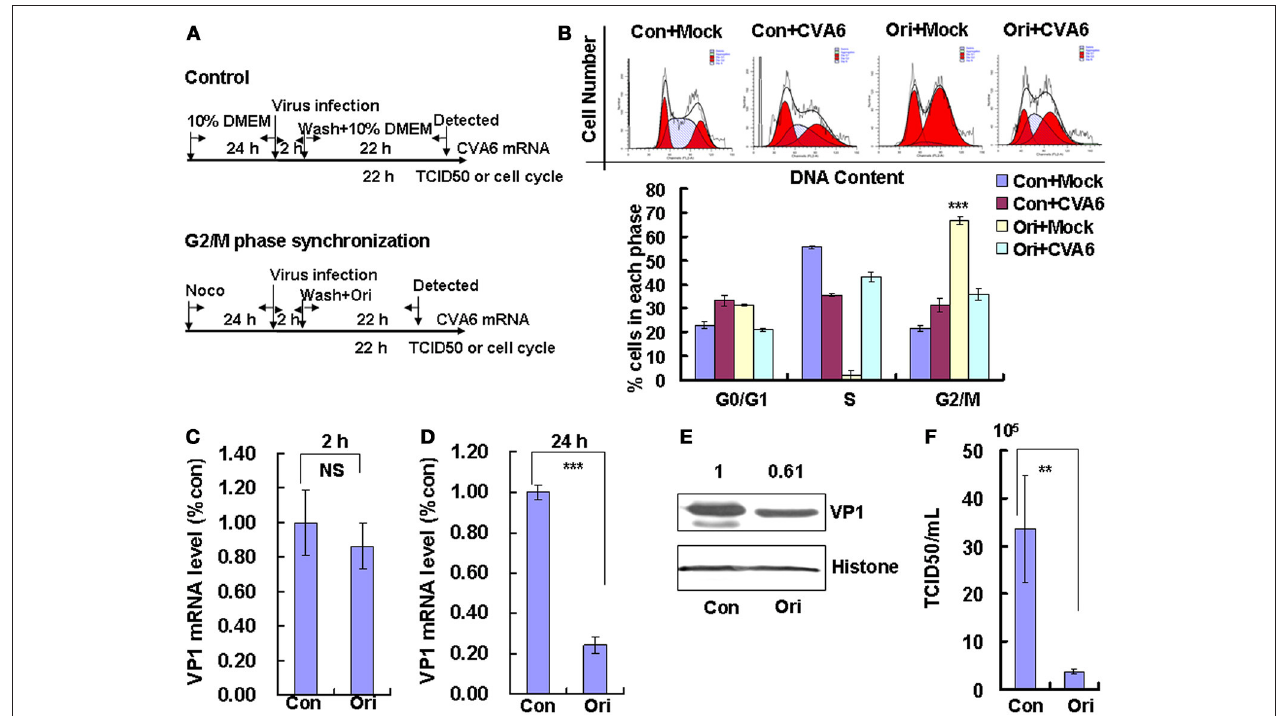
FIGURE 5 | G2/M-phase synchronization by Oridonin inhibits viral production. (A) RD cells were treated with or without 8 µ M Oridonin (Ori) for 24h, infected with mock (Mock) or CVA6 at an MOI of 1 for 2h, and then treated again with or without 8 µ M Oridonin for 24h. (B) Top panel: Flow cytometry determined the cell cycle profiles after growth in control medium (Con) or Oridonin (Ori)-containing medium for 24h. Bottom panel: The histograms indicating the cell cycle distribution were analyzed by the ModFit LT program. (C,D) By quantitative real-time PCR, CVA6 RNA levels were detected at 2h (C) and 24h (D) post-infection in G2/M phase-synchronized or non-synchronized cells. The results were standardized using GAPDH mRNA as a control and normalized to 1.0 in Con cells. *** P < 0.001. (E) By Western blot analysis, the expression of VP1 was determined after culture in control medium (Con) or Oridonin medium (Ori) at 24h post-infection. Histone is the loading control. The results are representative of three independent experiments. (F) At 24h post-infection, the TCID 50 /mL value of total progeny viruses (the supernatant and intracellular viruses) was determined in RD cells. The results represent the mean ± SD of three independent experiments. NS, no significant difference; ** P <